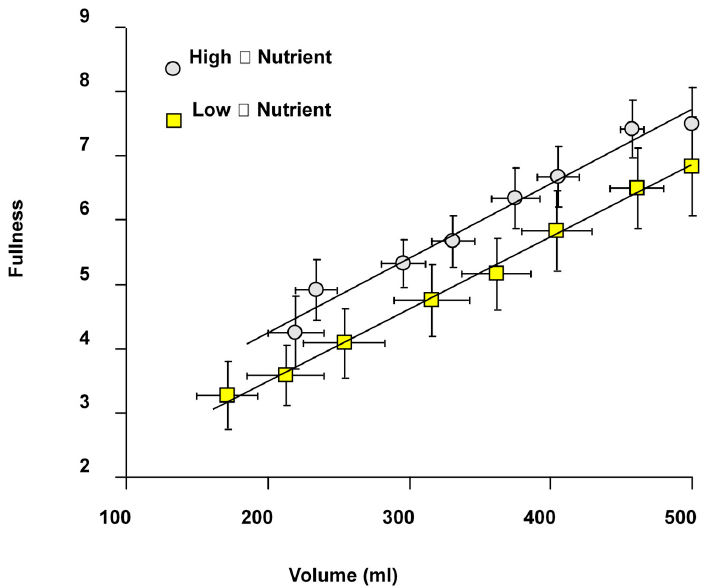
Figure 4. Correlation between sense of fullness and gastric volume after a high viscosity (17 Pa · s) and a low viscosity (0.01 Pa · s) nutrient meal containing 1350 kJ made up of 37% fat and 63% carbohydrate. The high viscosity meal generated a greater sensation of fullness. Reproduced from [11], American Physiological Society 2001, with permission.